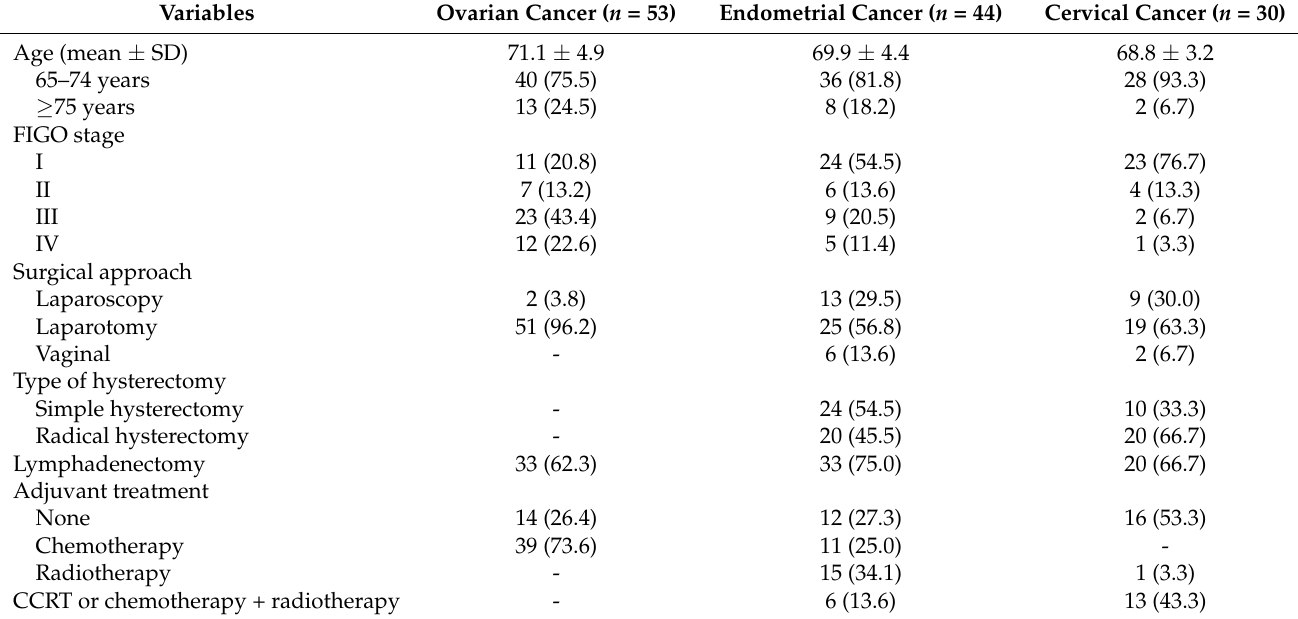
Table 2. Analysis of clinical characteristics according to the gynecologic cancer